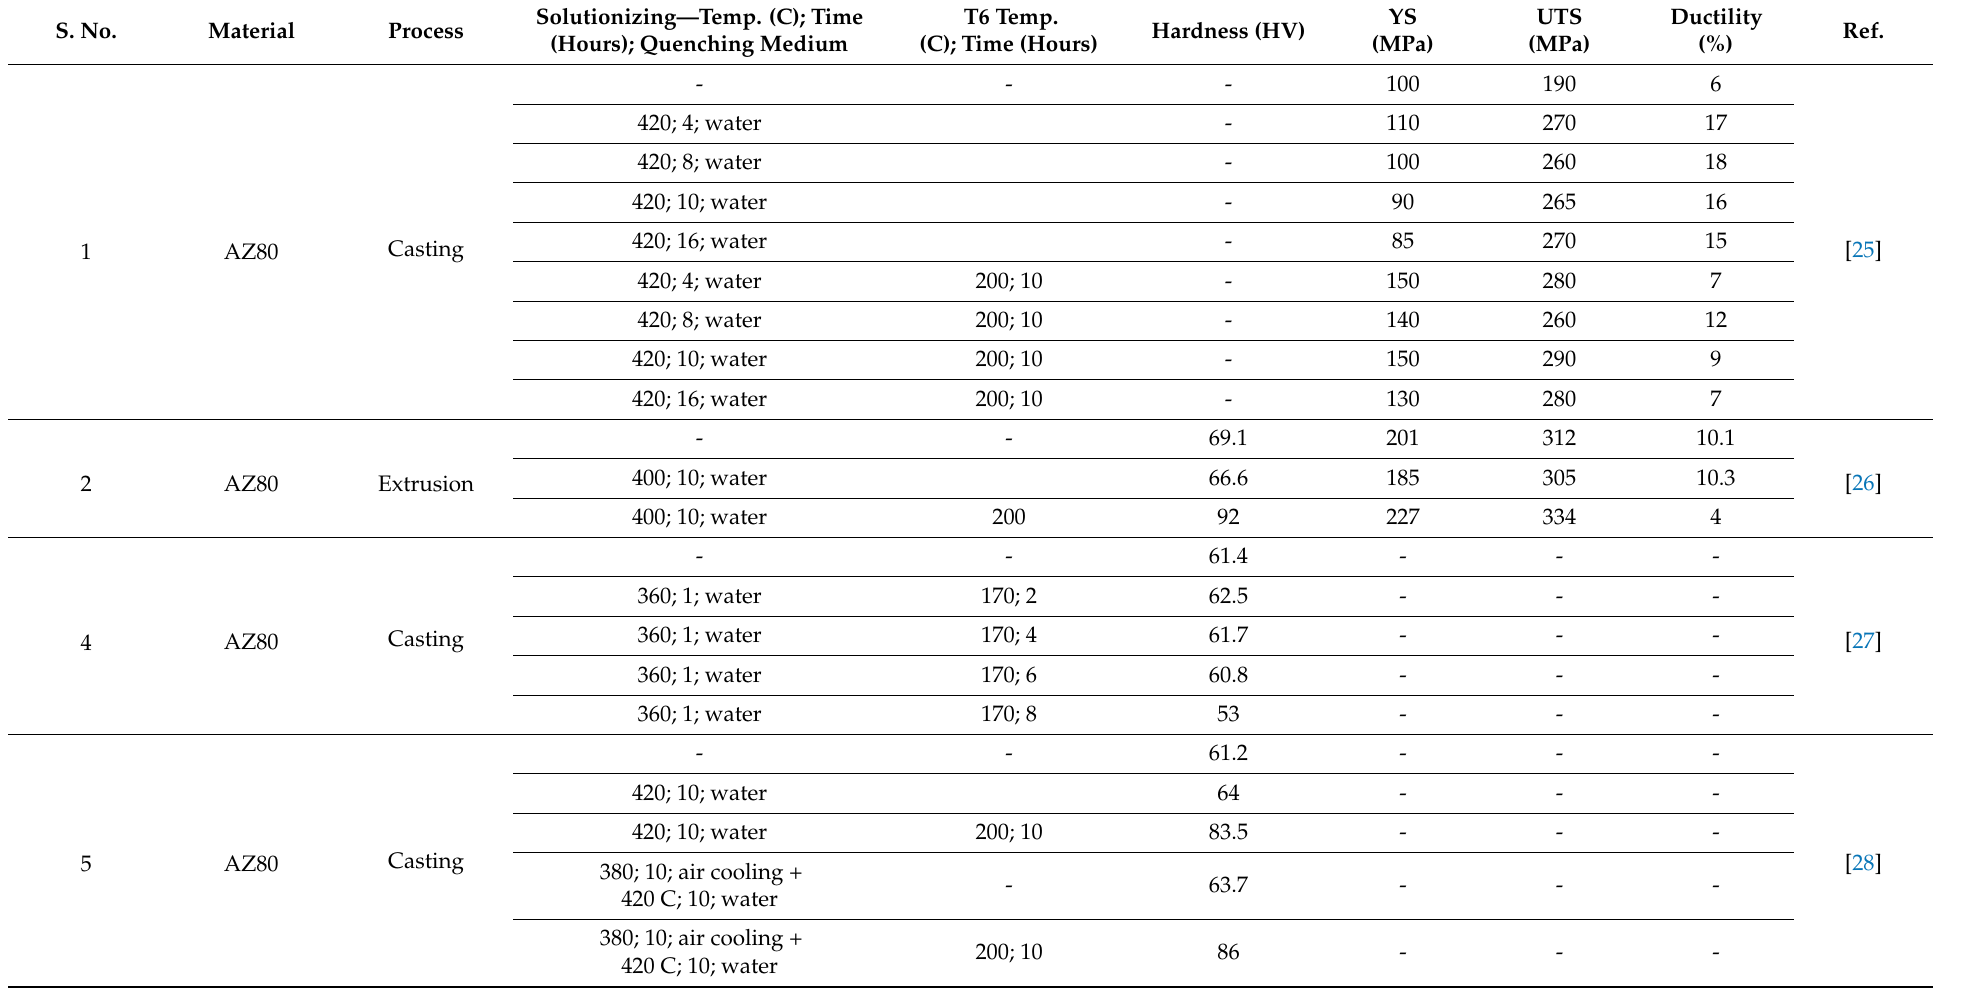
Table 1. Processing of AZXX Mg alloy and its corresponding mechanical